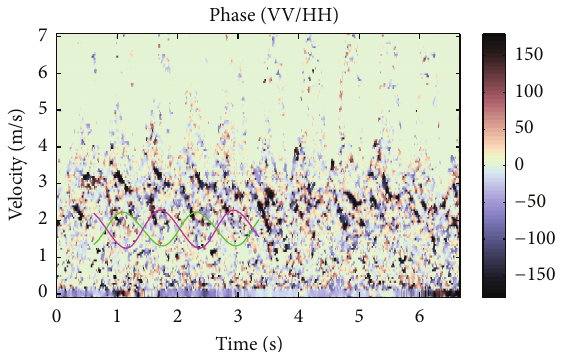
Figure 3: Polarimetric measurement of an unloaded human walk- ing toward the radar at Ka band from Figure 2 with the simulated elbow movement superimposed as red and green lines roughly corresponding to the areas of significant phase offset from zero.